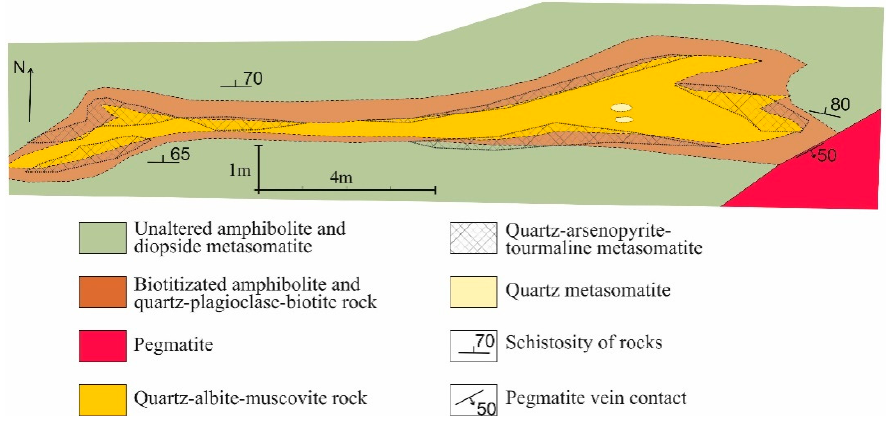
Figure 12. Scheme of zoning of metasomatic rocks in lens 2 (see Figure 9), logging of the trench. Table 4. Chemical composition (wt%) of granite porphyry and altered rocks of the Oleninskoe